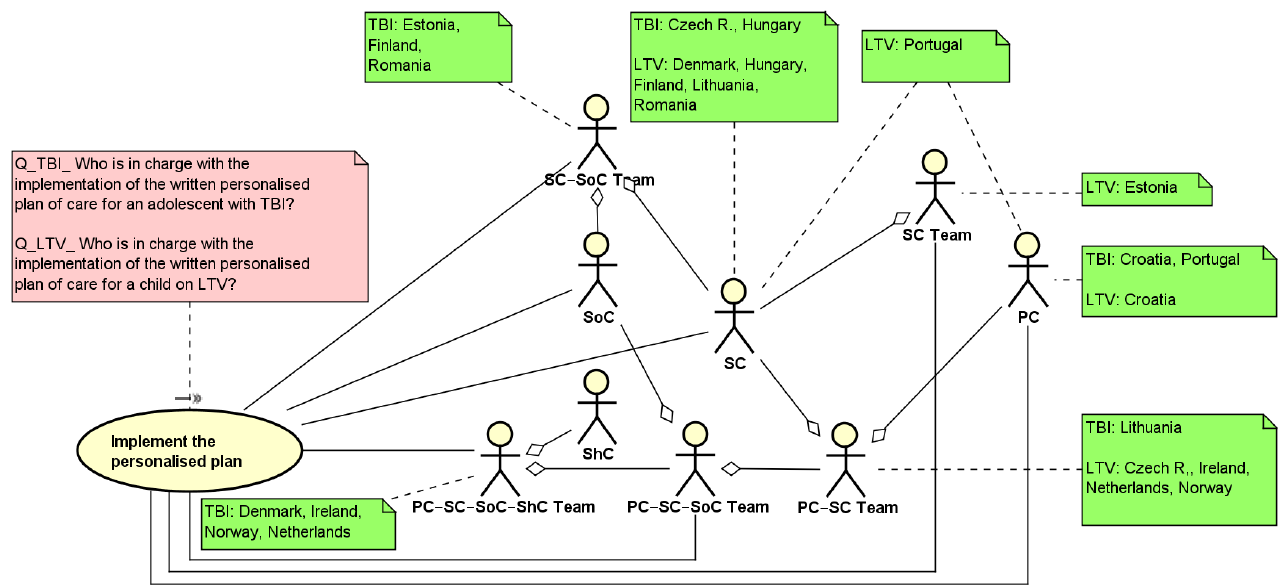
Figure 3. UML use case diagram describing the macro-activity: Implement the personalized plan. PC = Primary care professionals; SC = Secondary care; SoC = Social care; ShC = School care.